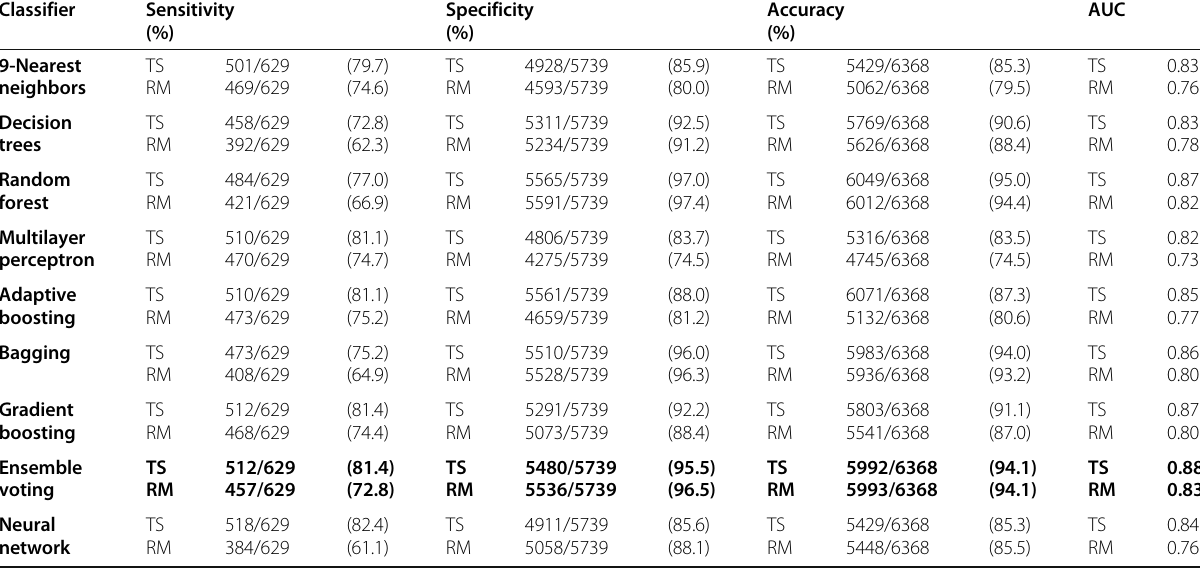
Table 3 Comparison of the classification results of the possible microcalcifications as normal tissue or radiologically true microcalcifications with temporal subtraction (TS) of mammograms or using only the most recent mammograms (RM), in a leave- one-patient-out cross-validation